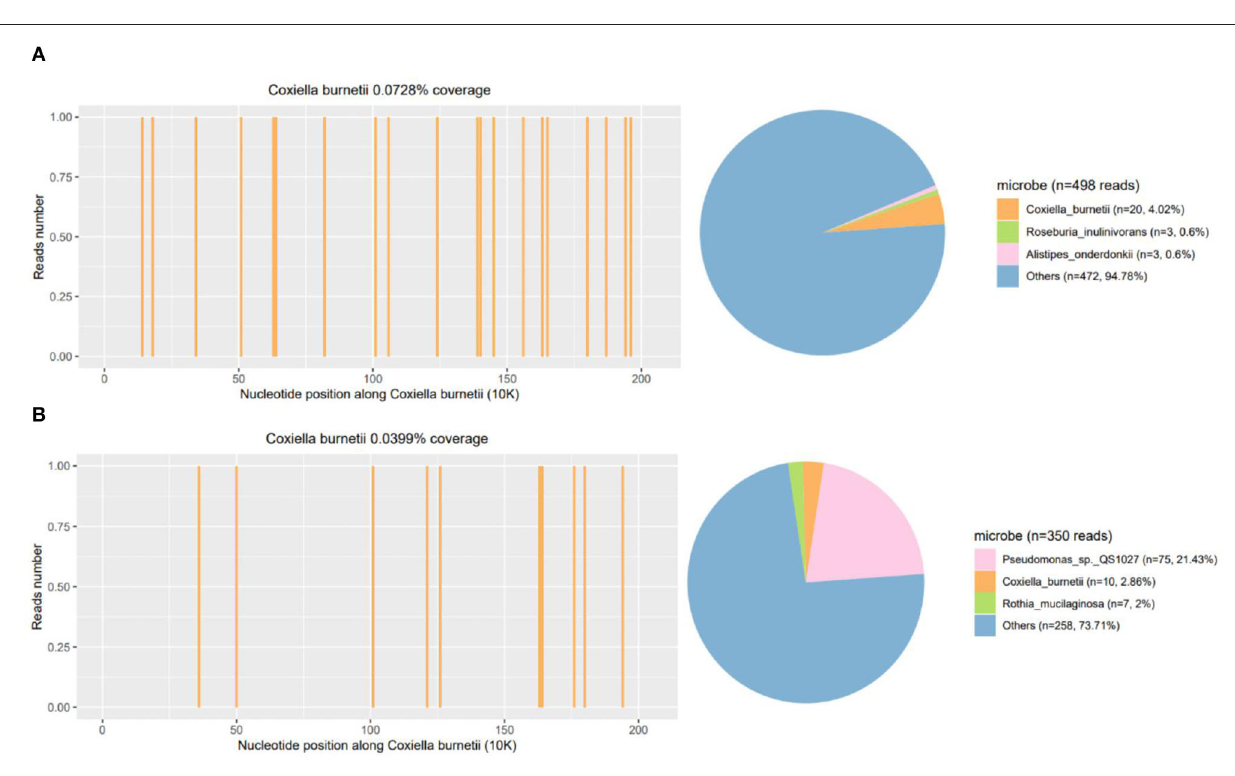
method, mNGS also can make a fast detection of difficult-to- culture pathogens such as C. burnetii (23, 24). Mingxing